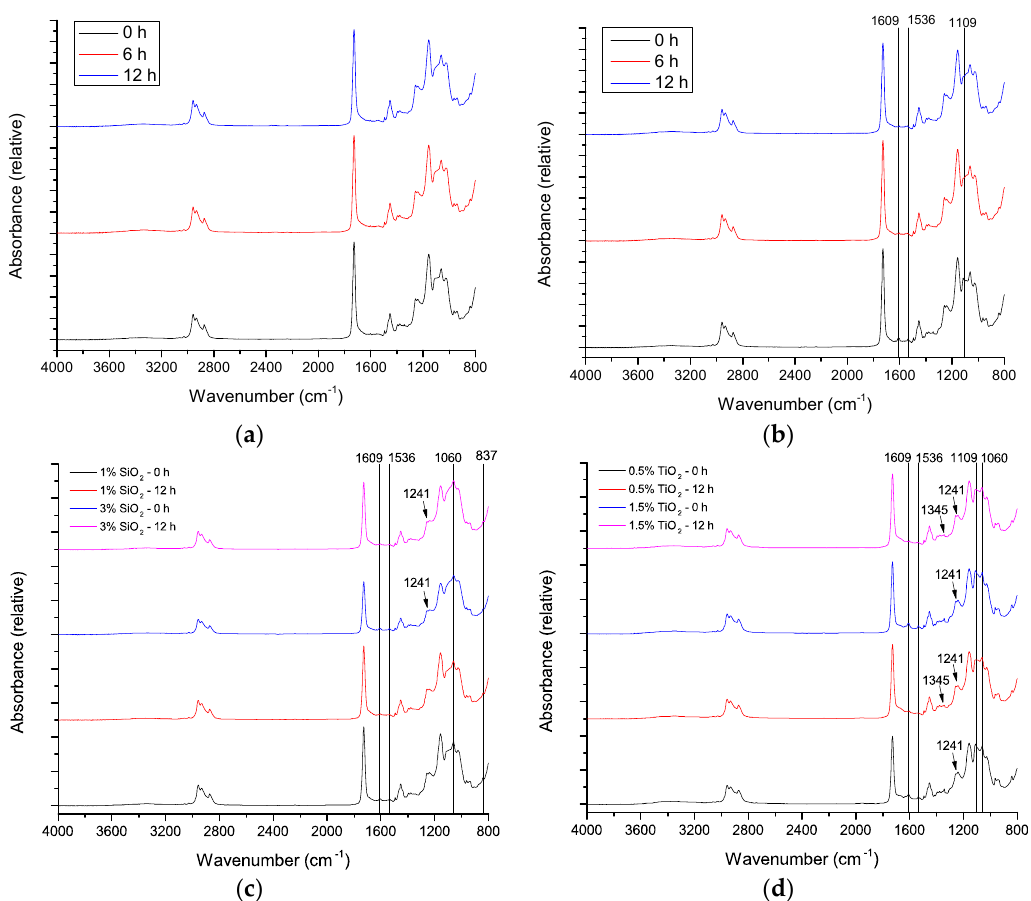
Figure 7. FTIR-ATR spectra of unaged and aged ( a ) transparent base; ( b ) FC without the nanoparticles; ( c ) FC with added SiO 2 nanoparticles; ( d ) FC with added TiO 2 nanoparticles.